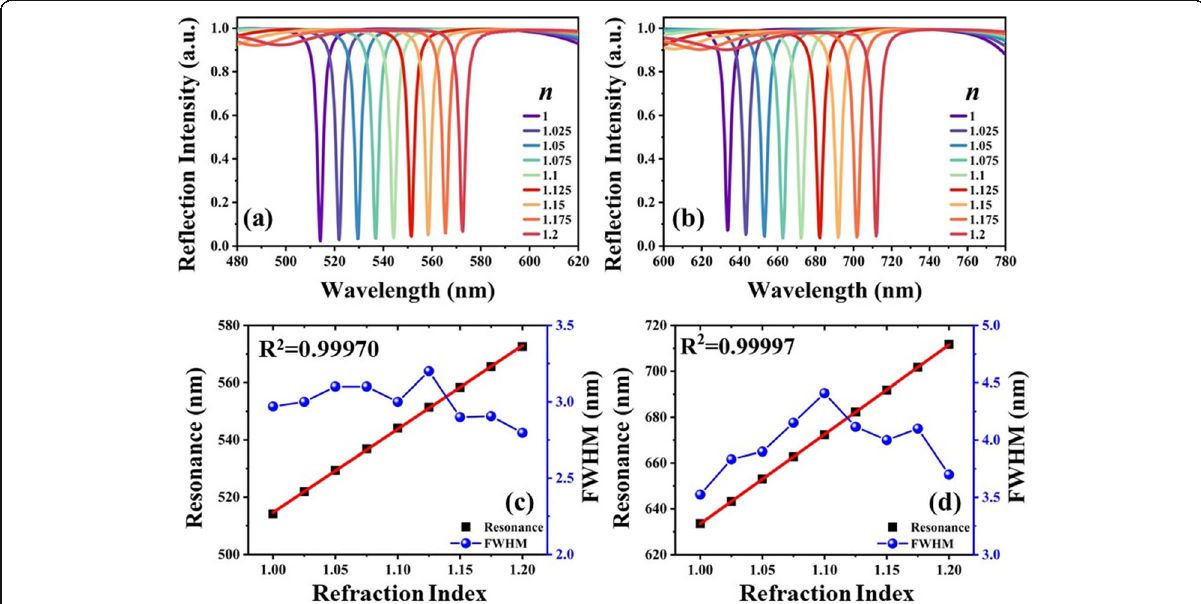
Fig. 7 Reflection spectra of TLNM exposed in surrounding environment with different refraction indexes ( n ) under the conditions of a D y = 350 nm, t = 210 nm, g = 490 nm, b D y = 450 nm, t = 280 nm, g = 580 nm. c , d The relationships of resonances, n values and corresponding FWHM values,